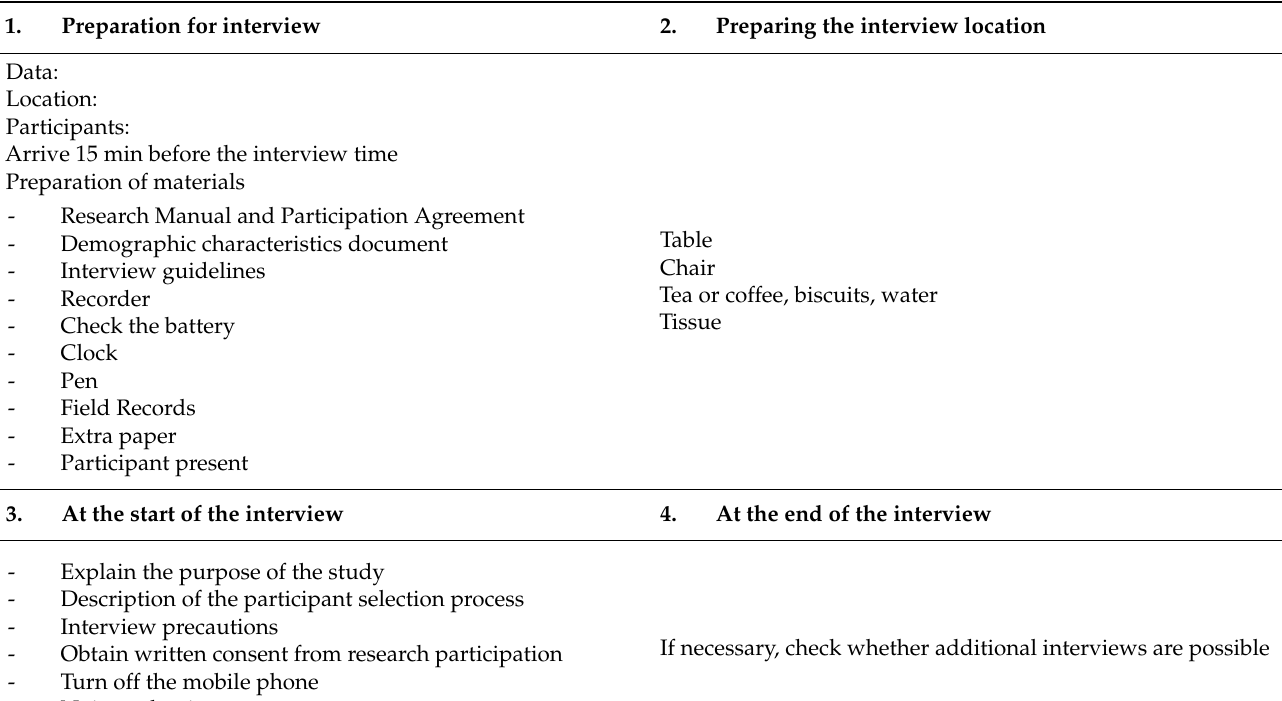
Table 1. Data collection